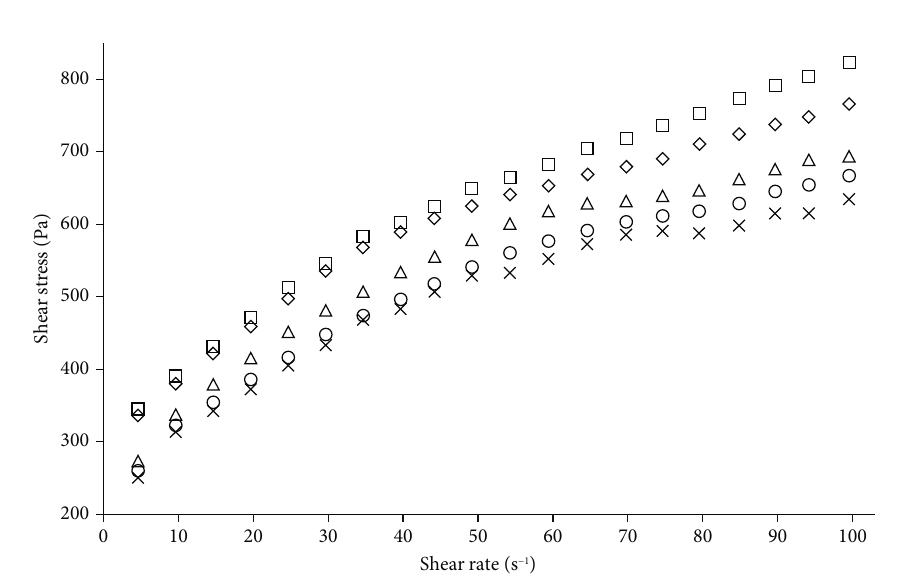
Figure 1: Shear stress ( τ ) and shear rate ( γ ) changes at 25 ° C for doughs with wheat to ackee aril fl our mass ratios of 100:00 (T1, □ ); 75:25 (T2, ◊ ), 50 :50 (T3, Δ ), 25 :75 (T4, O), and 0:100 (T5, х ).